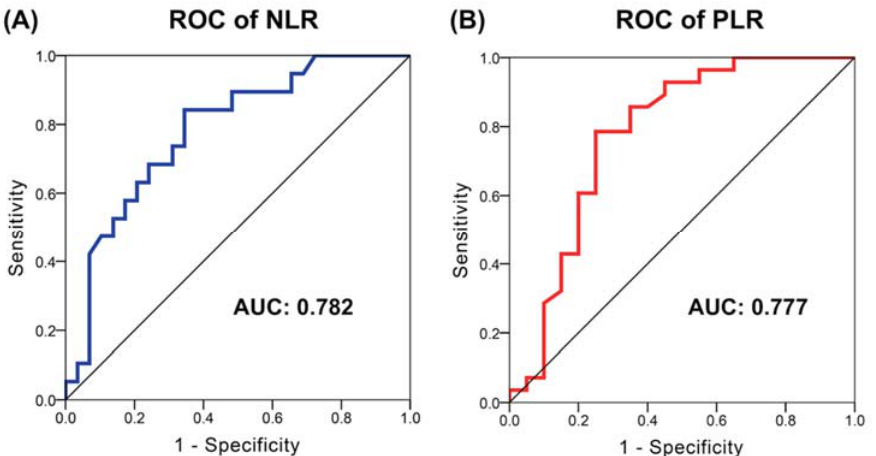
Figure 1. The receiver operating characteristic (ROC) curves of the NLR and PLR in patients